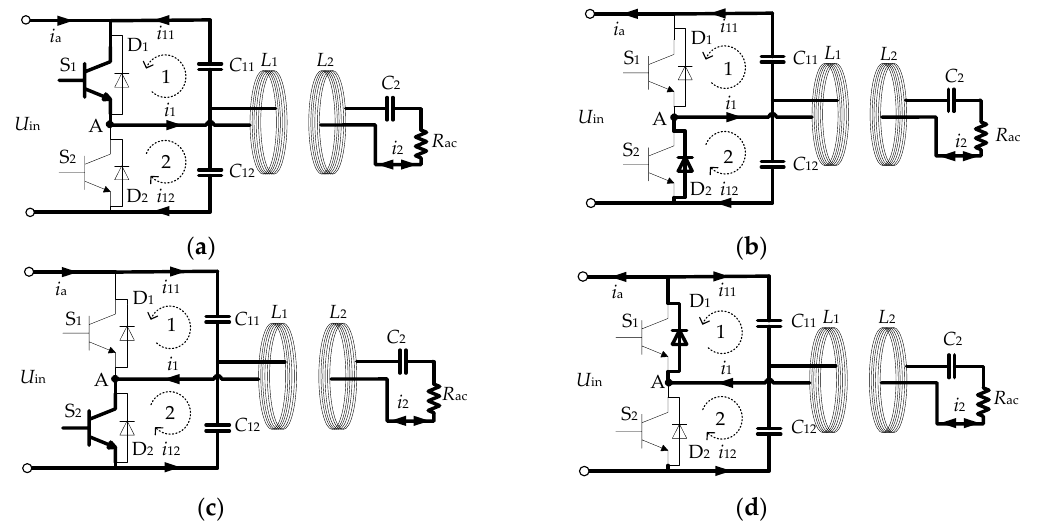
Figure 2. Operating modes of the proposed SHRC: ( a ) Mode 1 [ t 0 – t 1 ]; ( b ) Mode 2 [ t 1 – t 2 ]; ( c ) Mode 3 [ t 2 – t 3 ]; ( d ) Mode 4 [ t 3 – t 4 ].